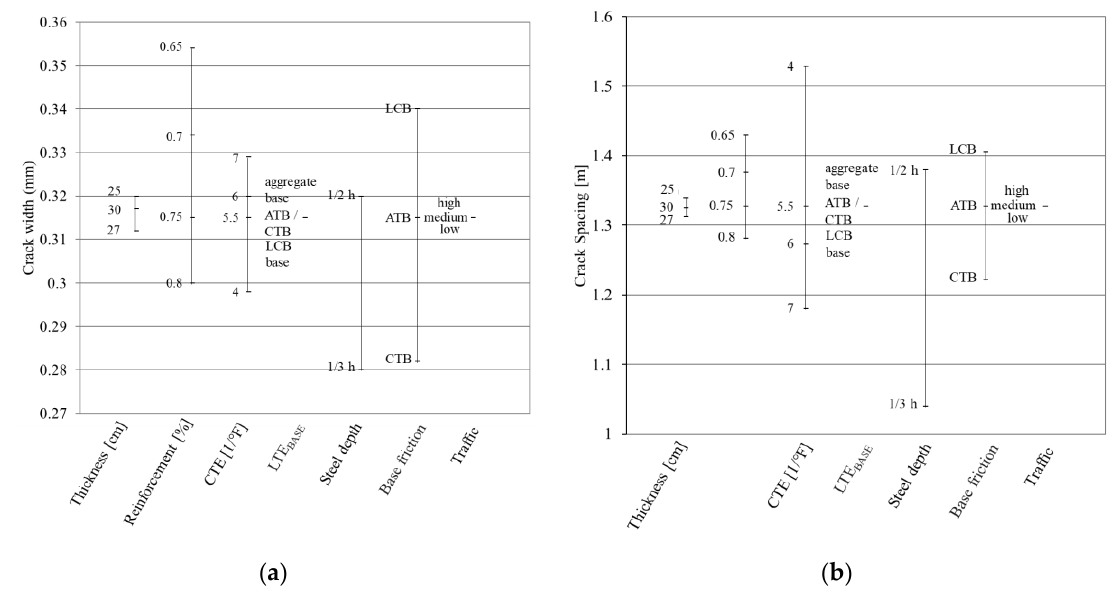
Figure 7. Relative impact of the individual variables on the ( a ) crack spacing, and ( b ) crack width by the MEPDG. ATB: asphalt-treated base; CTB: cement-treated base, LCB: lean concrete base.